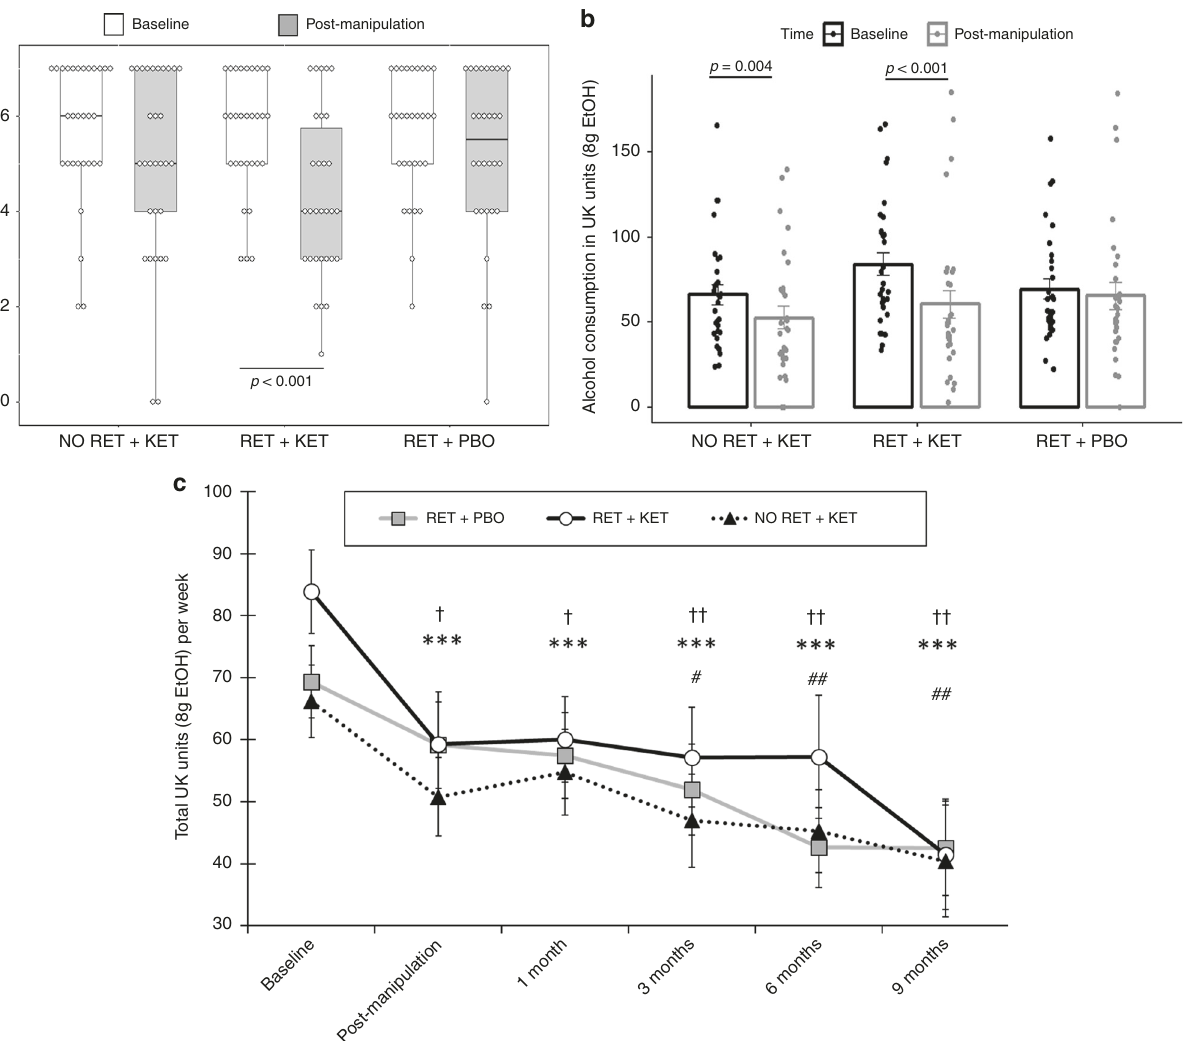
Fig. 2 Changes in drinking outcomes. a Reduction in number of drinking days from Day 1 (baseline) to Day 10 (post manipulation) in RET + KET only. Dots are individual data points, boxes and lines represent mean ± IQR, whiskers represent range. b Reductions in total alcohol consumption per week (UK units) across the same period bars are mean ± SEM and dots individual data. c Changes in alcohol consumption across all measured time points. Data points and bars represent mean/SD using all participant data available at each time point. Signi fi cant reductions from baseline are denoted by † for No RET + KET, * for RET + KET and # for RET + PBO. One symbol = p < .05, two symbols = p < .01, three symbols = p < .001. In all panels, p -values are from F tests of sim p le contrasts against baseline within-group. Individual data points for b , c are given by group in Fig. 3. Source data are provided as a Source Data fi